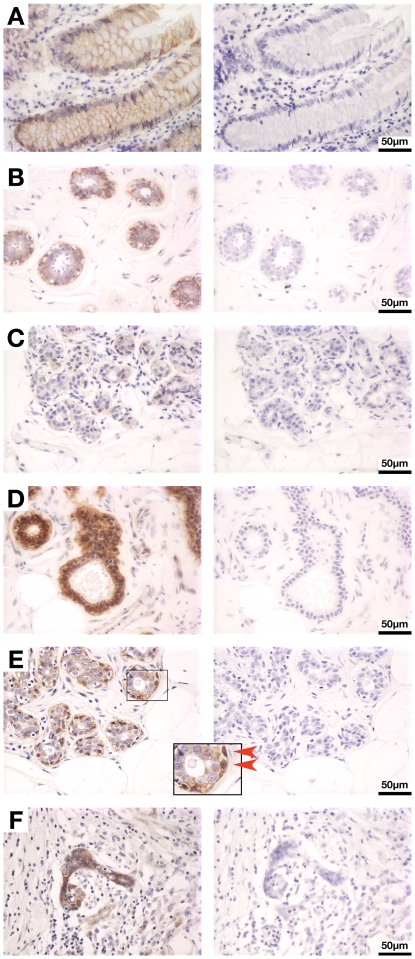
ß-catenin staining patterns of benign human tissues.The 2nd Generation Breast Cancer Progression TMA purchased from the NCI Cancer Diagnosis Program was subjected to ß-catenin IHC using BD Transduction Labs anti-ß-catenin antibody Clone 14 as previously described [43] and counterstained with hematoxylin. As a control, serial sections were stained in parallel omitting primary antibody (right-hand panels). (A) Normal colon. (B–E) Normal breast. (F) Ductal carcinoma in situ. The image in (E) illustrates the positive nuclear ß-catenin staining observed in myoepithelial cells in some benign breast cores (inset, enlargement of boxed area; red arrowheads indicate positively-staining nuclei).